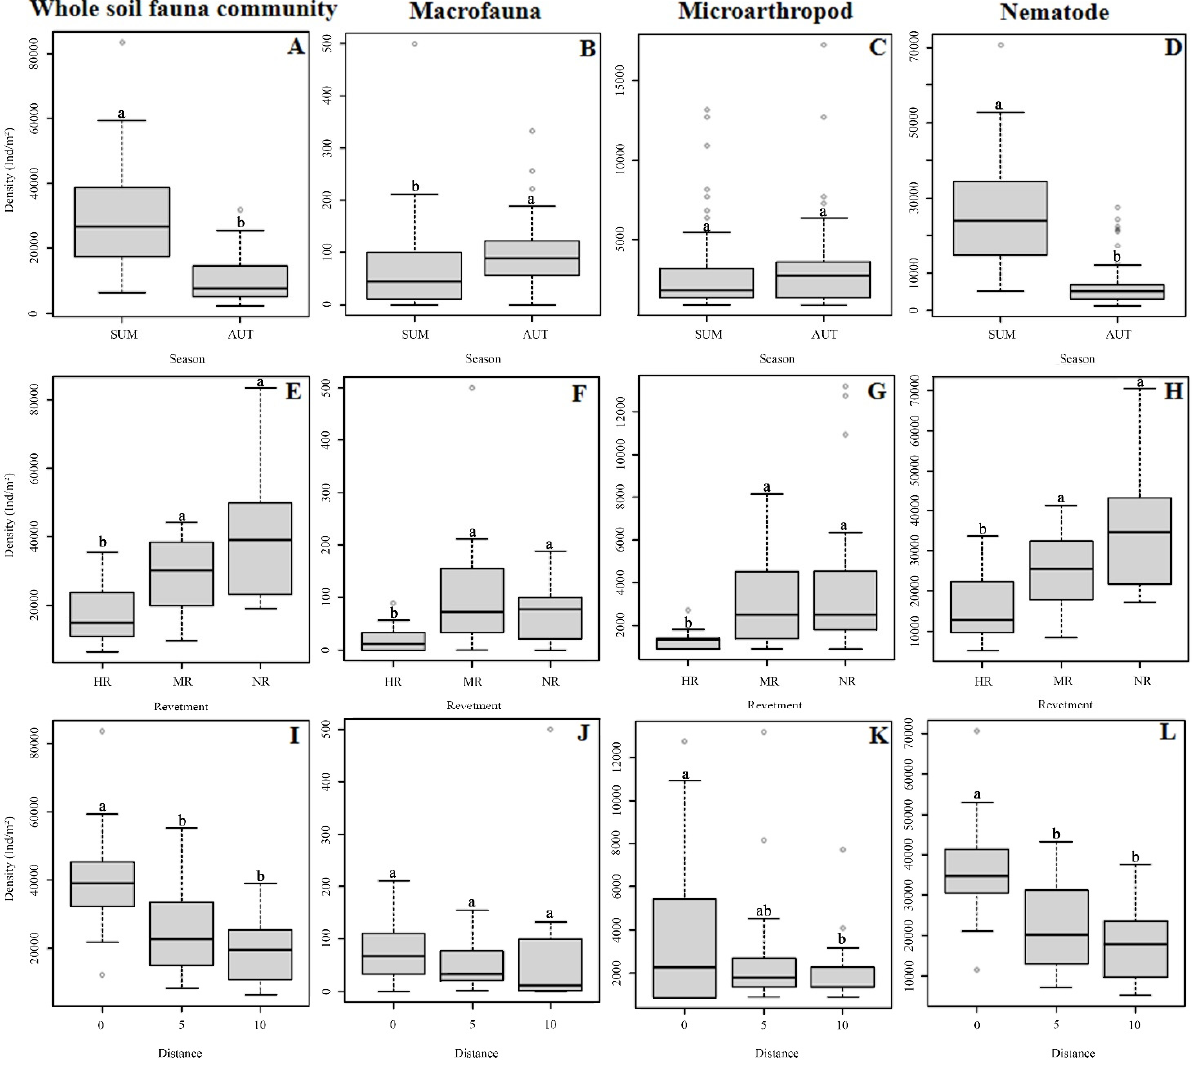
Figure 2. Abundance of soil animal groups in two seasons ( A – D ) and abundance of soil animal groups of three revetment types ( E – H ) and three distances ( I – L ) in summer. Each box plot displays the median (bold lines), the interquartile range (box), minimum and maximum values (whiskers), and outliers (circles). Different lower-case letters indicate significant differences among revetment types or distances ( p < 0.05). The plots of three revetment types and distances in autumn are not presented due to non-significance. NR = natural riverbank zone, MR = mixed-type revetment zone, HR = hard-type revetment zone; SUM = summer, AUT = autumn; 0, 5, and 10 represent the different distances (m) from the land–water boundary. It is the same below. Table 1. Results of testing for the effects of revetment type, distance, and their interactions on soil fauna abundance and richness. χ 2 statistics for the likelihood ratio test and p values are reported.